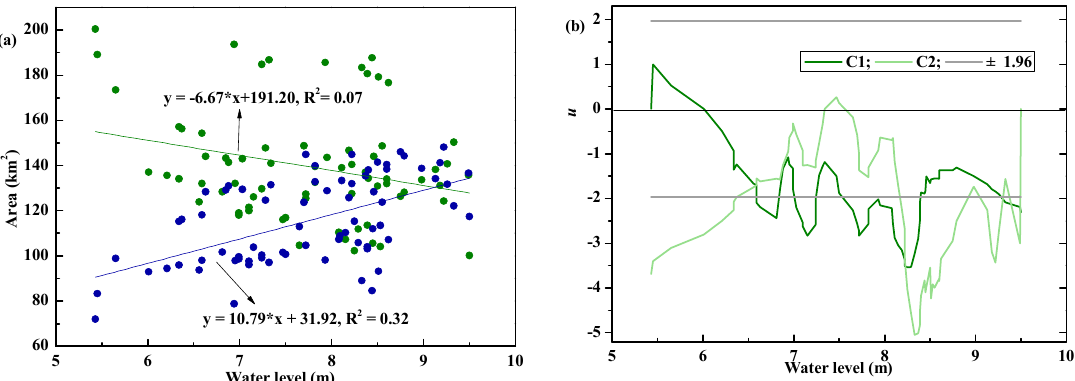
Figure 3. The variation of P. australis cover and open water area with water level fluctuations. ( a ) P. australis cover (showed as • ) and open water area (presented as • ) varied with water level fluctuations; ( b ) the abrupt changes detected by Mann-Kendall method for P. australis cover.